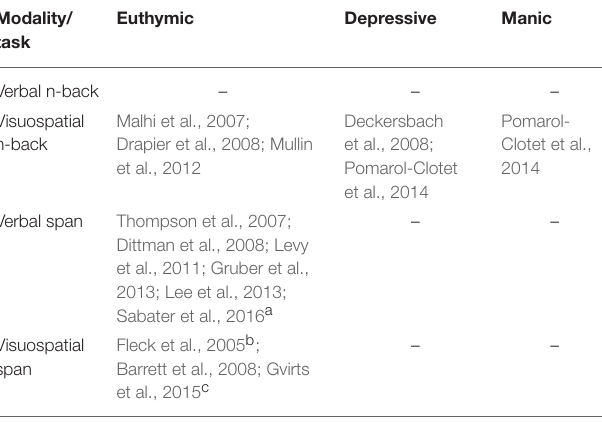
TABLE 4 | Summary of mental WM operations and phonological and visuospatial modalities in three emotional phases in BD presented in the selected